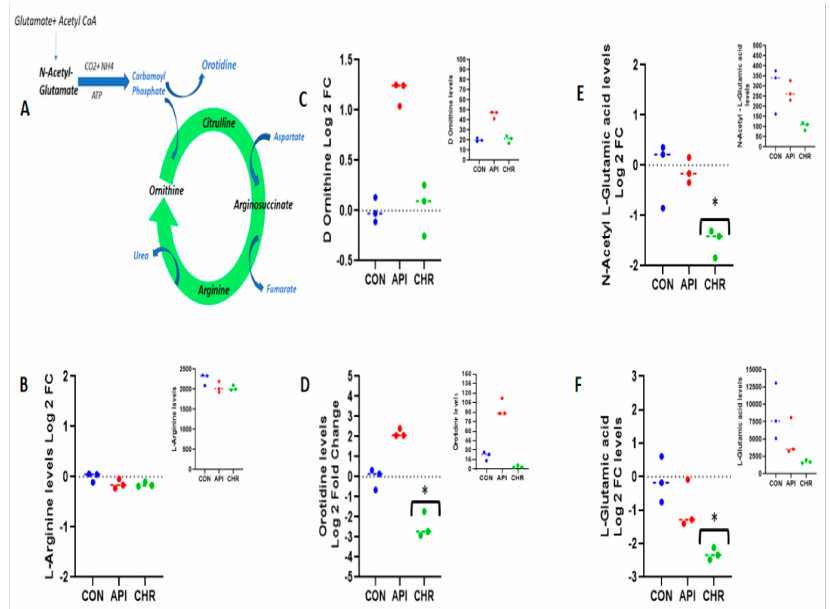
Figure 9. Chrysin-mediated regulation of metabolites in the urea cycle: Based on the metabolite panel, the urea cycle was the other top regulated metabolic pathway. ( A ) Glutamate and acetyl CoA act as major substrates for the formation of N-acetyl glutamate and finally carbamoyl phosphate, which is the precursor for substrates in the urea cycle including citrulline, arginine, and ornithine. The raw values (upper inserts) and the log2 fold change values of ( B ) L-arginine, ( C ) D-ornithine, and ( D ) orotidine are expressed, respectively. The protonated forms of N-acetylated glutamate and glutamate, N-acetyl L-glutamic acid, and L-glutamic acid with the raw values (upper inserts) and calculated log2 fold change values are represented in ( E , F ), respectively * p <